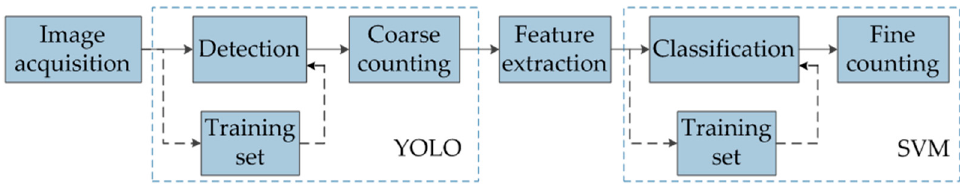
Figure 3. Flow chart of counting and recognition system of flying insects.